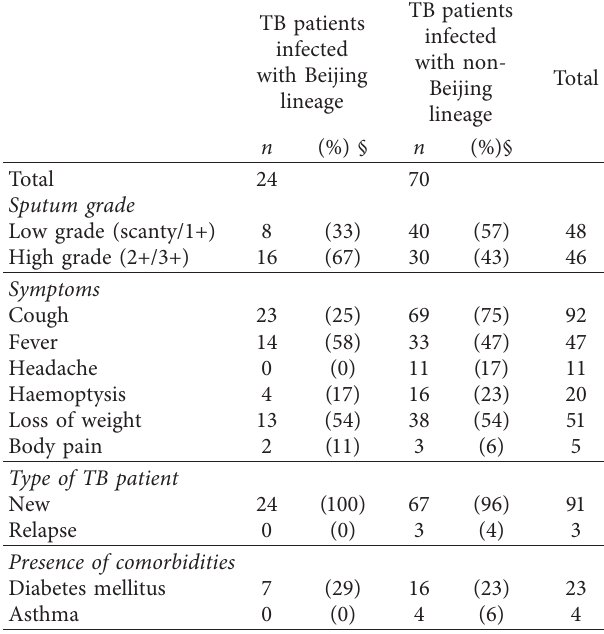
Table 3: Clinical presentation among pulmonary